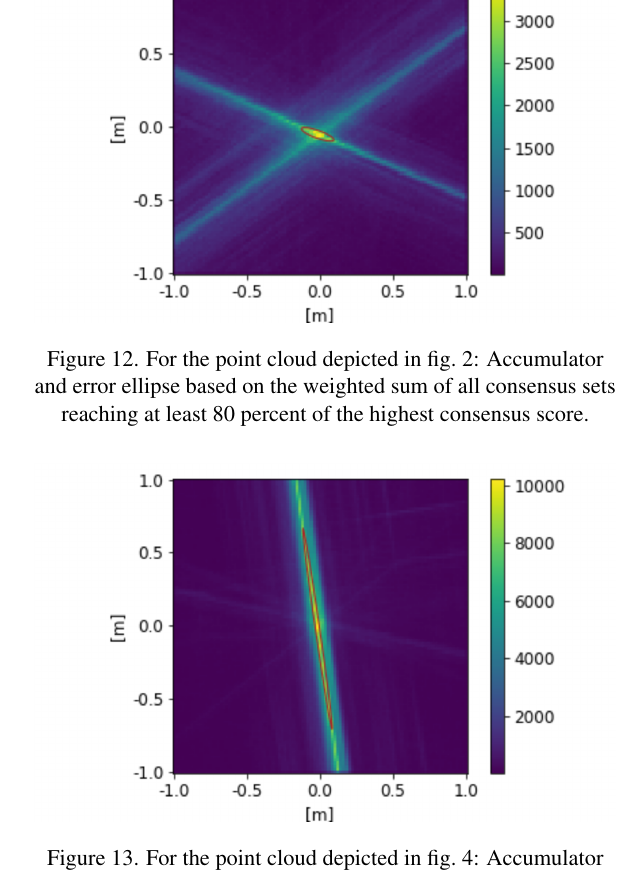
Figure 13. For the point cloud depicted in fig. 4: Accumulator and error ellipse based on the weighted sum of all consensus sets reaching at least 80 percent of the highest consensus score.